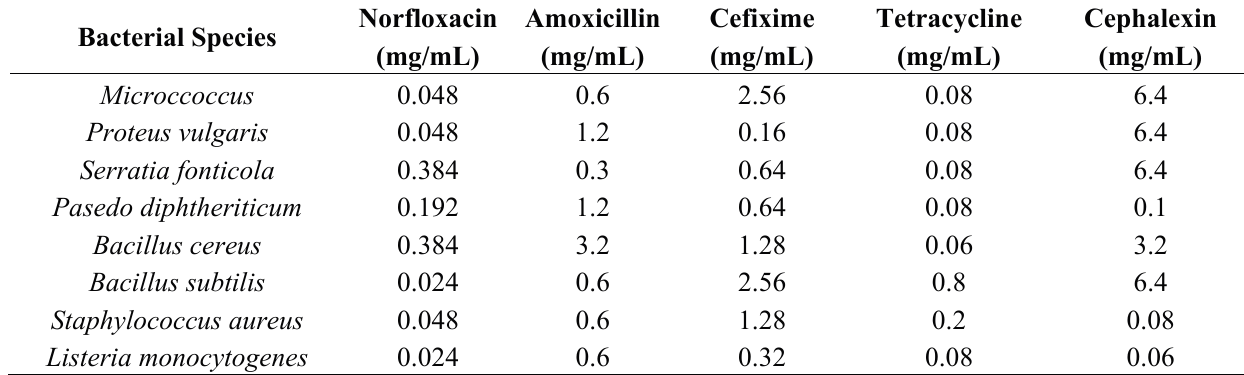
Table 1. MIC (mg/mL) of different antibiotics against selected bacterial species (values are average of at least three experiments).